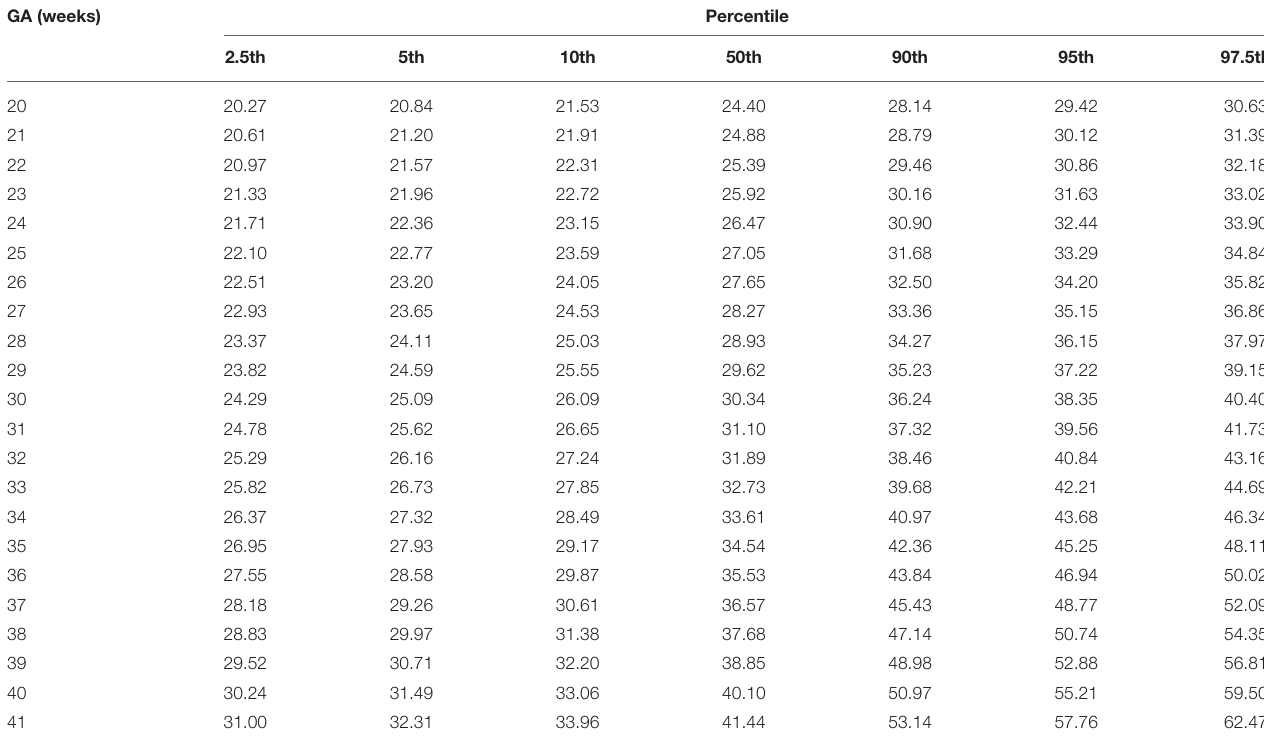
TABLE 2 | Longitudinal reference percentiles of fetal ascending aorta global circumferential strain (GCS, %). GA (weeks)